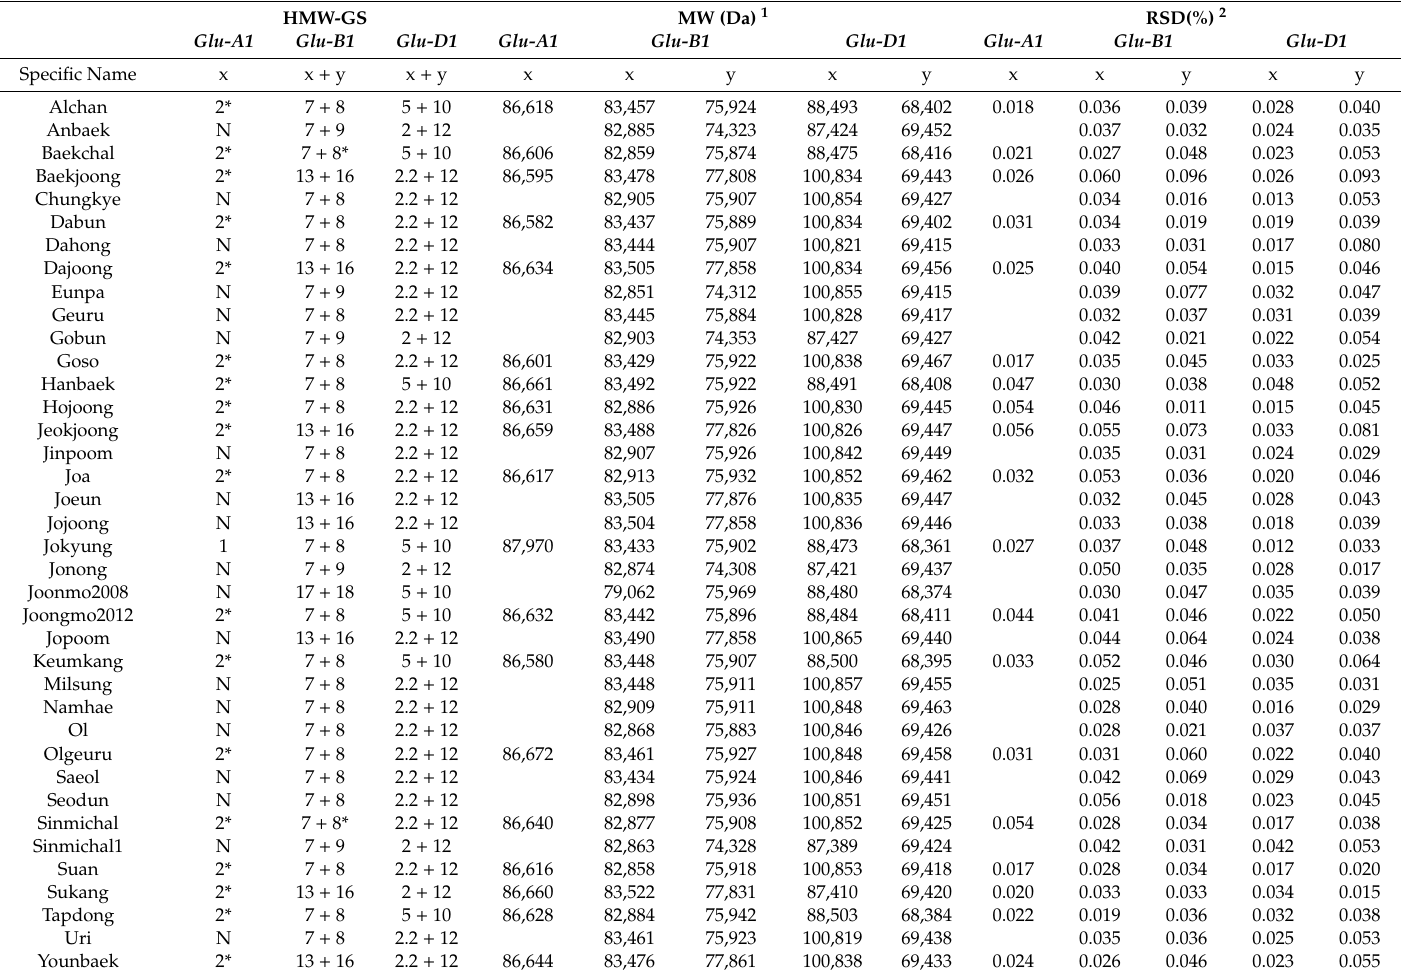
Table 4. Reproducibility of molecular weights (MW) for HMW-GS in Korean wheat cultivars by